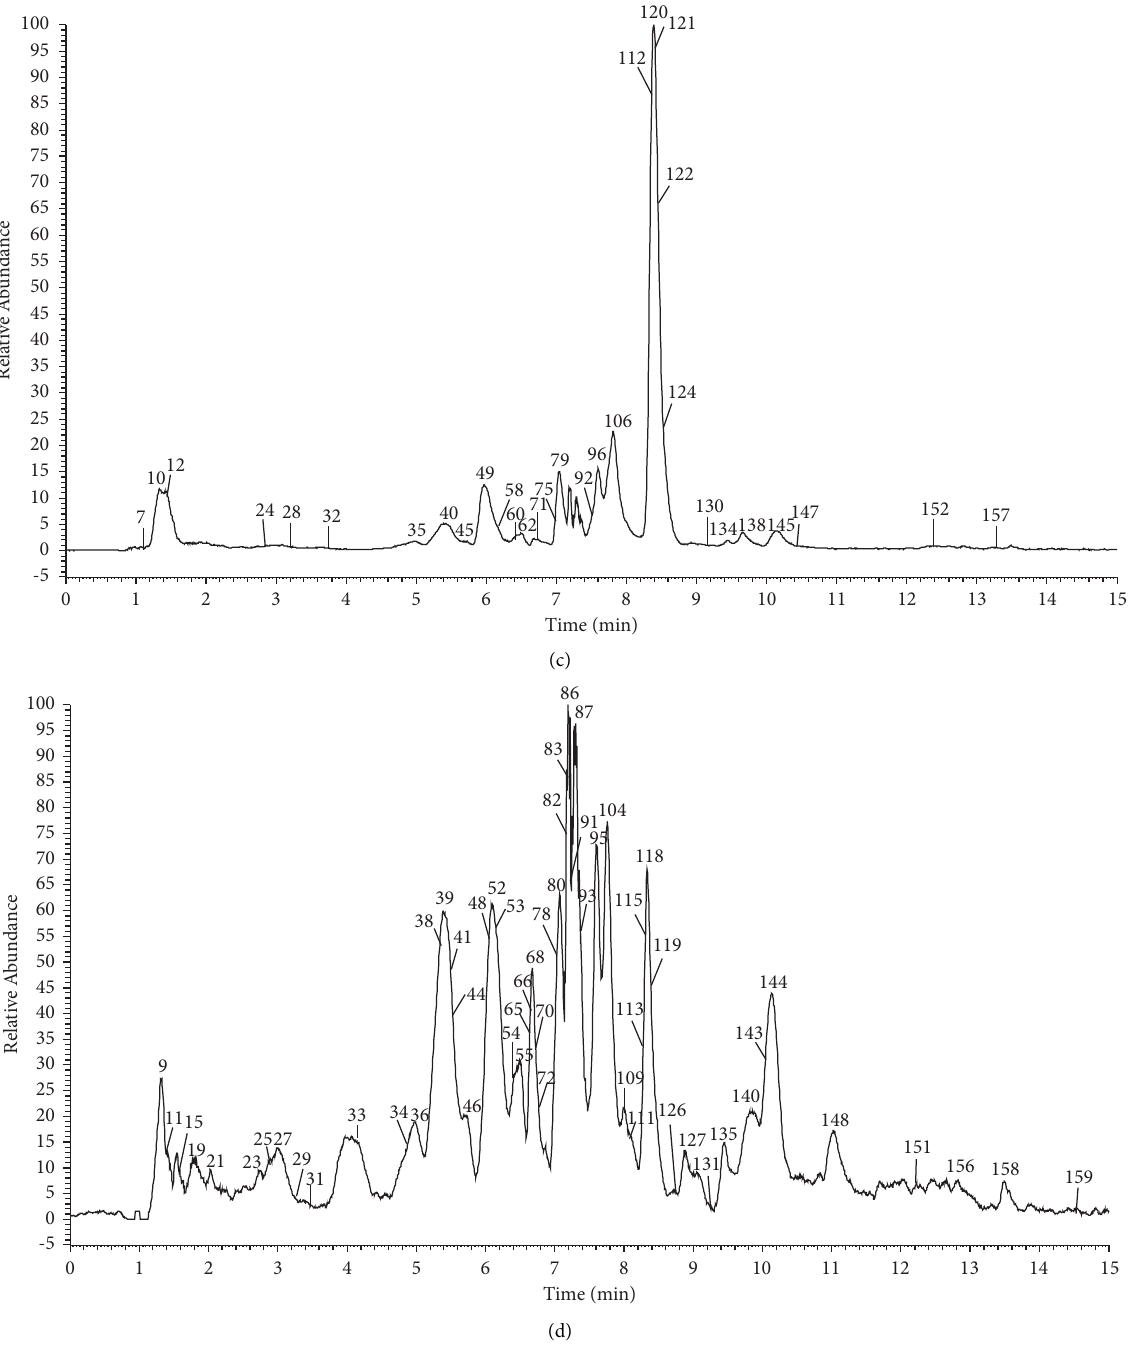
Figure 1: Te high-resolution extraction ion chromatography of Diospyros lotus L in negative ion mode (a) 167.0350, 169.0142,